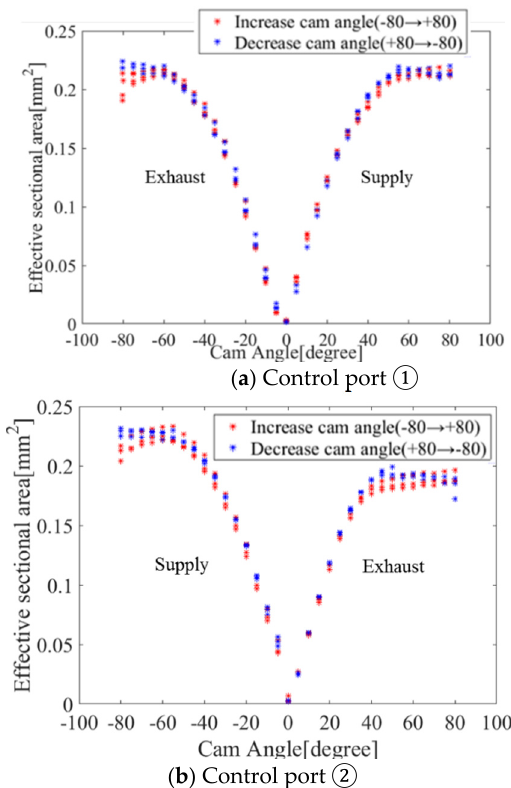
Figure 11. Flow characteristics of developed pinch-type valve.